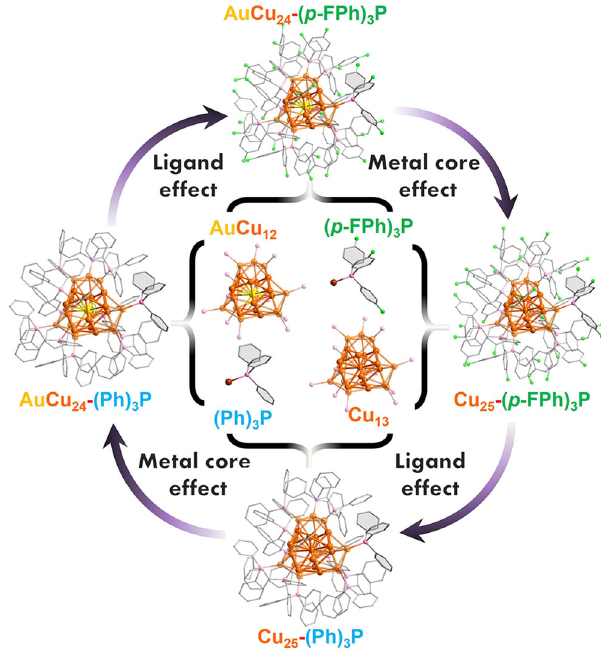
Fig. 1 Total structures and anatomy of Cu 25 -(Ph) 3 P, Cu 25 -( p -FPh) 3 P, AuCu 24 -(Ph) 3 P and AuCu 24 -( p -FPh) 3 P. Color code: orange, Cu; yellow, Au; green, F; violet, P; gray, C. The H atoms are omitted for